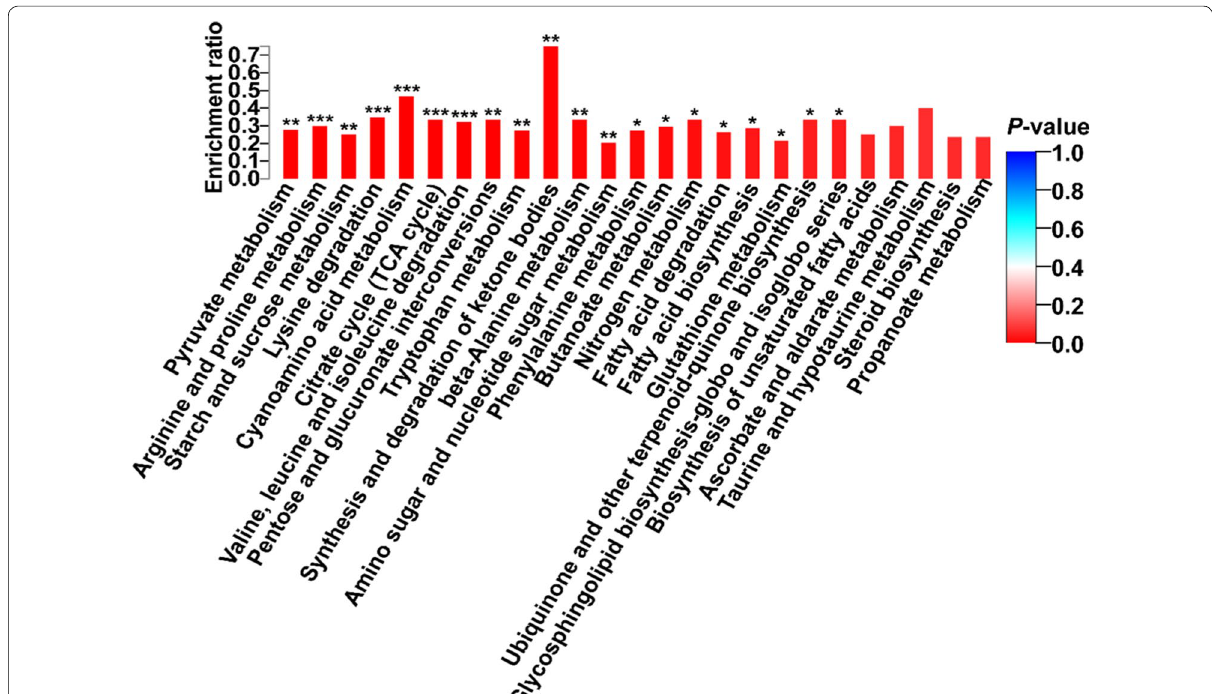
Fig. 3 Analysis of the DEGs between KB10 and FM10 based on the KEGG enrichment map. * P < 0.05, ** P < 0.01, *** P < 0.001